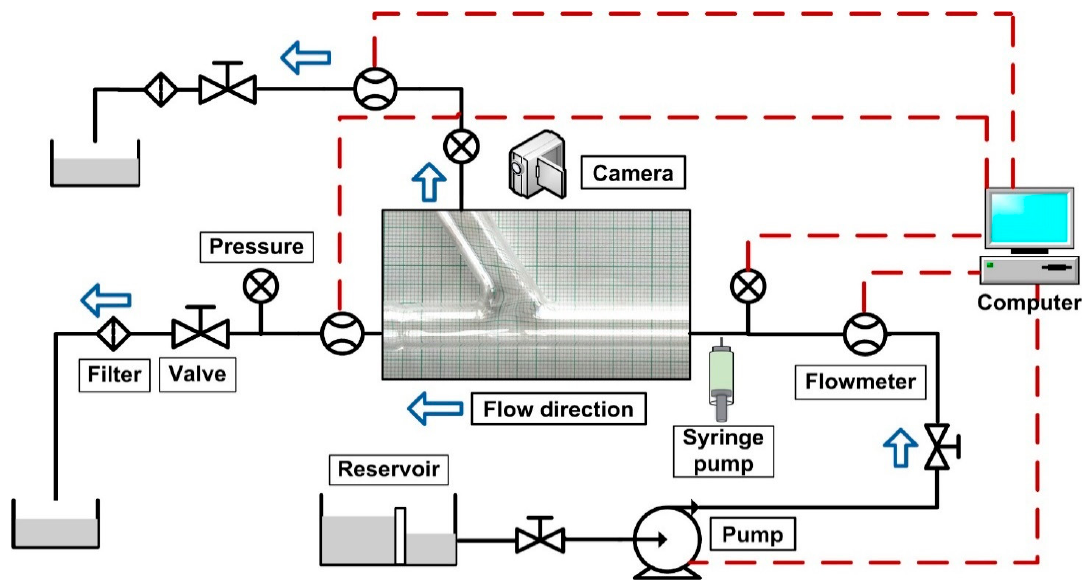
Figure 3. The experimental setup used for artery bifurcation investigations. The block diagram of the main recirculating flow loop contained a flowmeter, particle injection mechanism—syringe pump and test section—bifurcation model, valve, particle filter, reservoir, and centrifugal pump.